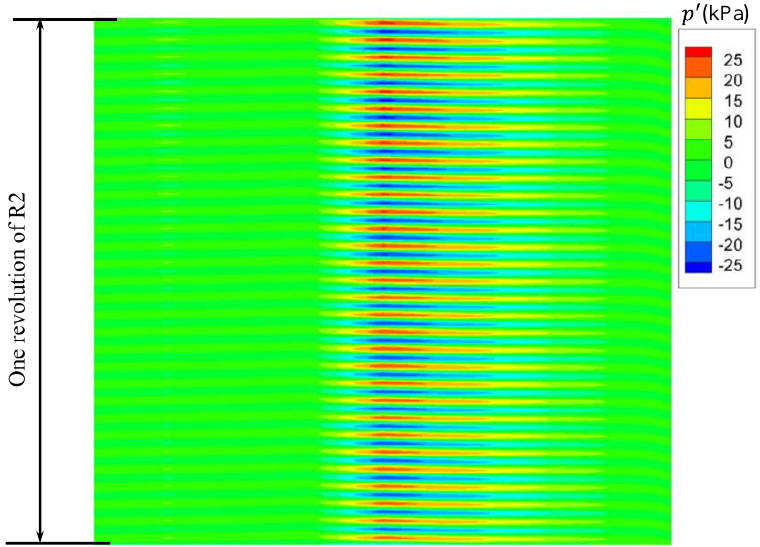
Figure 17. The distribution of the 1st harmonic of the R2 sweep disturbance .